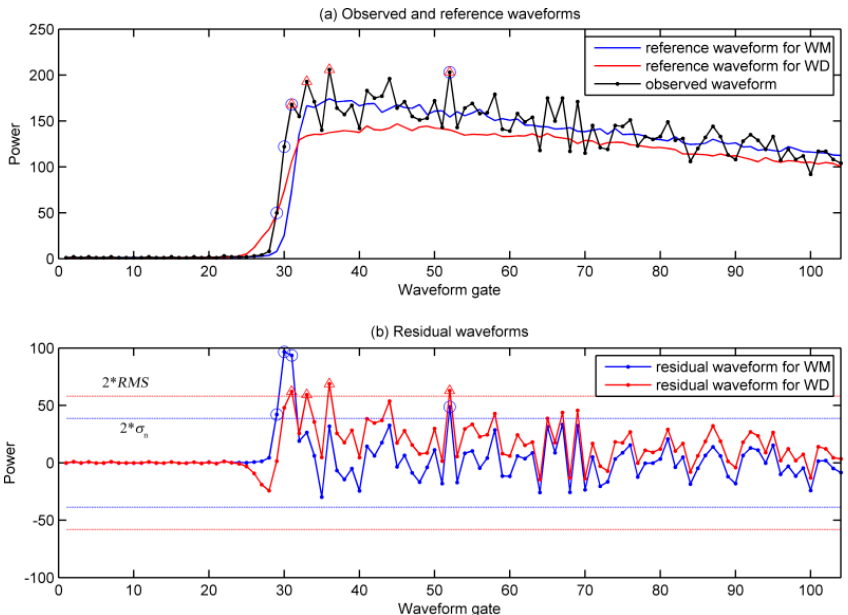
Figure 3. Comparison between waveform modification (WM) and waveform decontamination (WD) in the case of Figure 2. Reference waveforms for the two methods are shown in ( a ). The blue one is used in the WM, averaged within 20–30 km offshore. The red one is used in the WD, averaged between 0–20 km offshore. The black curve with dots is the observed waveform at latitude 38.84°. Its corresponding residual waveforms are shown in ( b ). The blue circles and the red triangles denote anomalous samples detected by WM and WD, respectively.